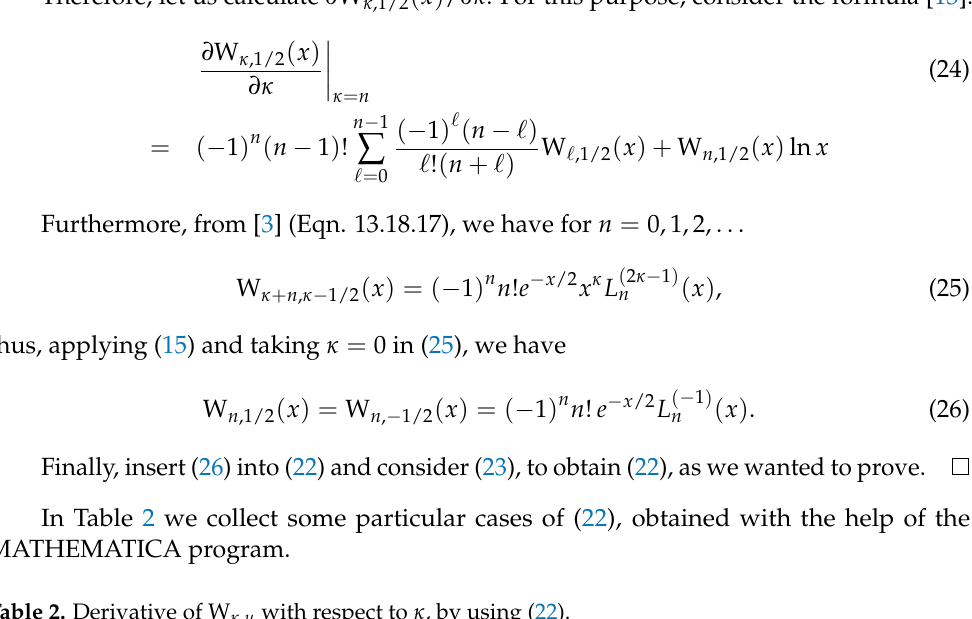
Table 2. Derivative of W κ , µ with respect to κ , by using